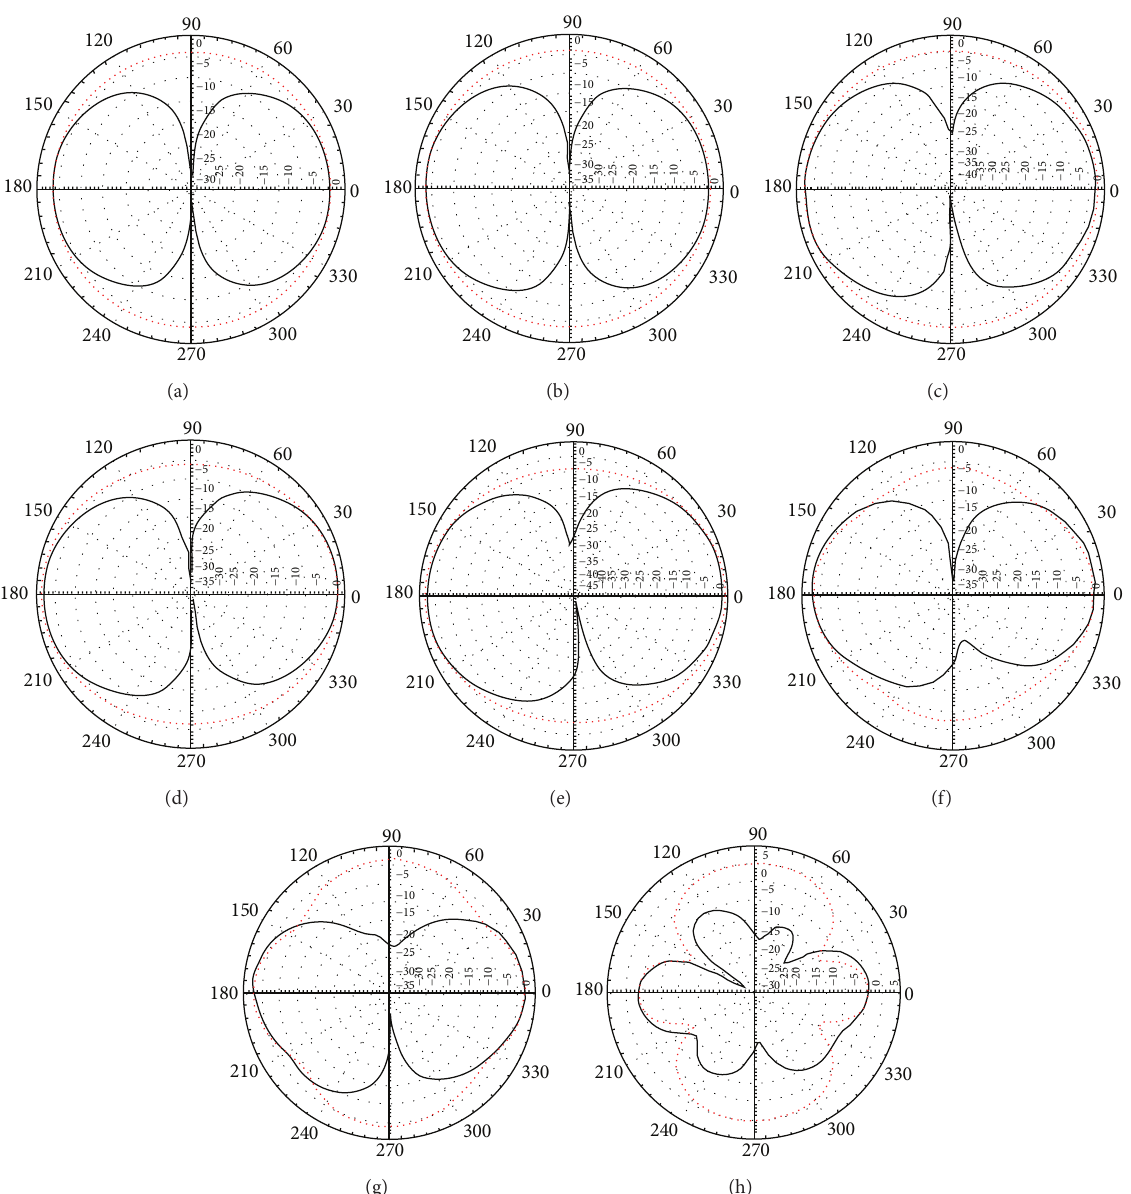
Figure 7: Normalized simulated radiation patterns of the antenna at (a) 3GHz, (b) 4.5GHz, (c) 6GHz, (d) 7.5 GHz, (e) 9 GHz, (f) 10.5GHz, (g) 12GHz, and (h)